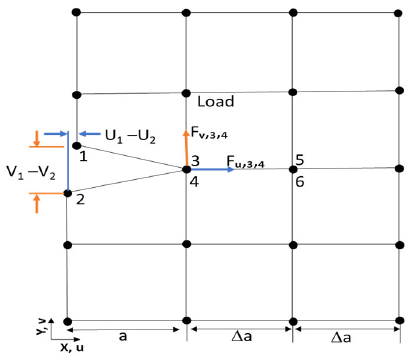
Figure 2. Schematic diagram of the virtual crack closure technique (VCCT) used for the simulation of crack growth in the TC layer.